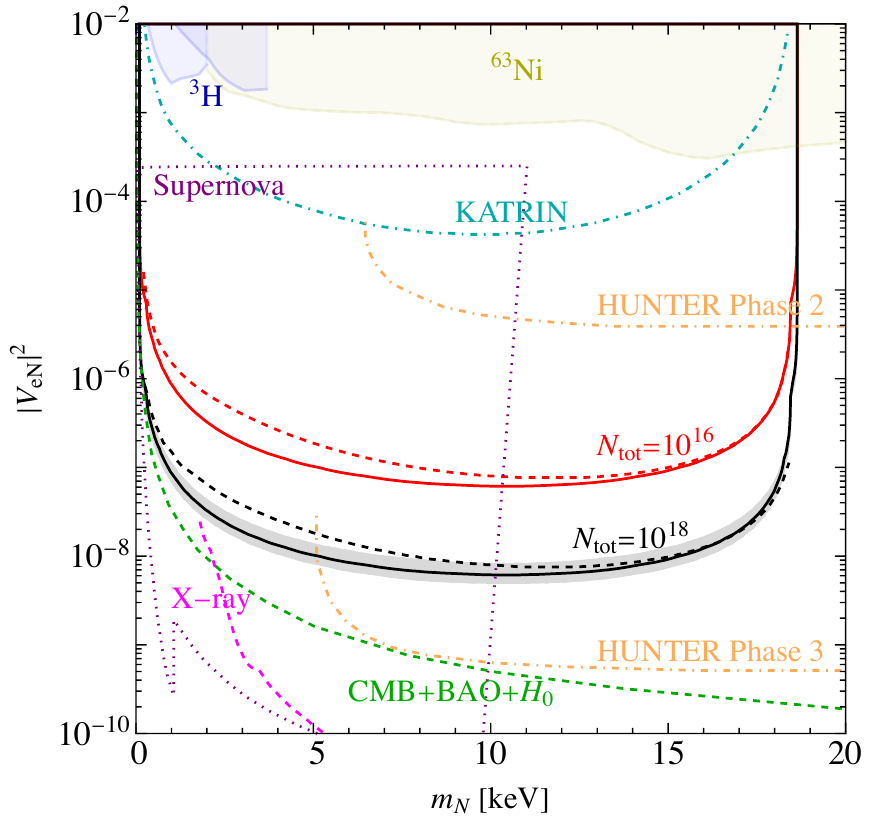
Figure 11 . Projected sensitivities to the active-sterile mixing | V eN | 2 as a function of sterile neutrino mass m N at 95% CL, for a total number of events N tot = 10 16 (red solid) and N tot = 10 18 (black solid), alongside corresponding expected sensitivities of TRISTAN (dashed red and dashed black). The gray shaded band corresponds to the 1 σ variation of the 95% CL for a large number of simulations. The shaded regions are excluded by 3 H (blue) and 63 Ni (yellow) searches together with future experimental constraints expected from KATRIN (cyan dot-dashed) and HUNTER (orange dot-dashed). The dotted lines show current astrophysical constraints from: x-ray data (pink) [44], CMB+BAO+ H 0 observations (green) [45] and supernova data (purple)